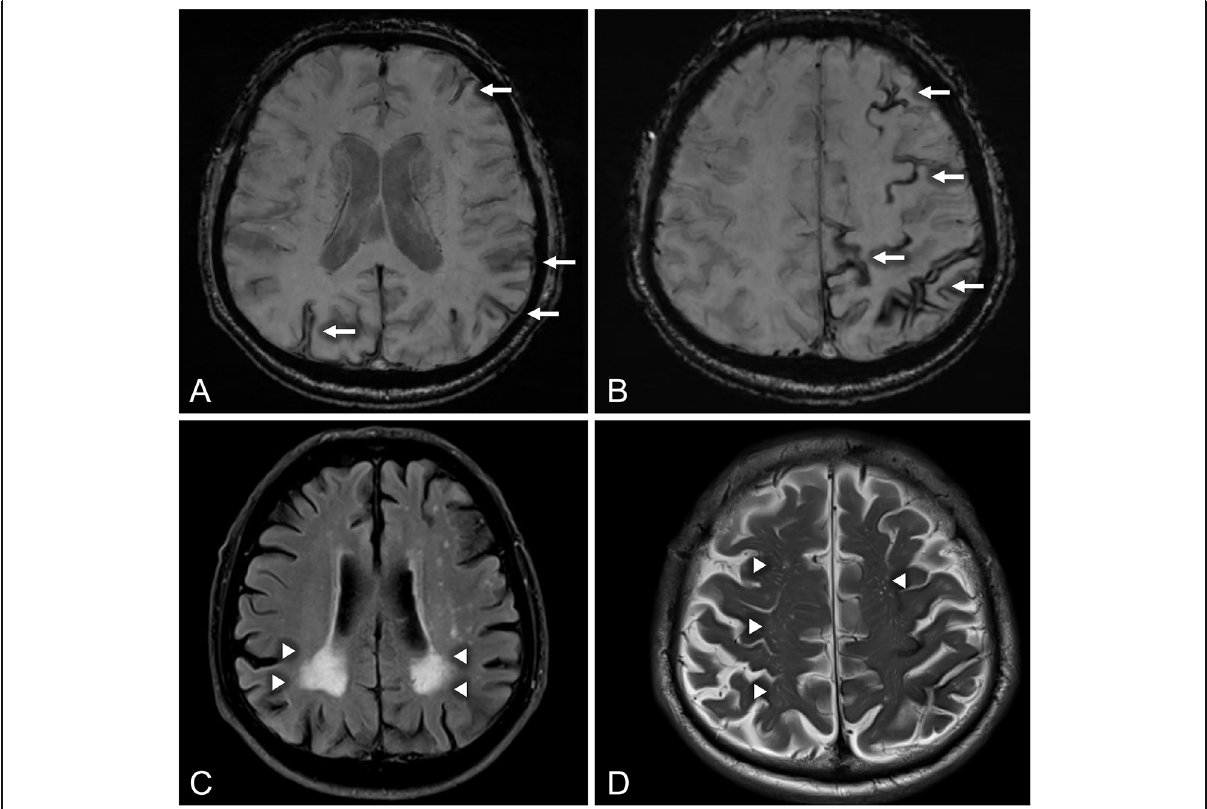
Fig. 1 Neuroimaging findings in a patient with transient focal neurological episodes. Legend: Axial brain MRI with susceptibility-weighted imaging sequence showing rims of low signal coating the sulci of both cerebral hemispheres with left predominance, suggestive of cortical superficial siderosis (Panel a - b , arrows). Axial brain MRI with fluid-attenuated inversion recovery sequence showing symmetrical periventricular white matter hyperintensities with occipital predominance of Fazekas grade 3 (Panel c , arrowheads). Axial brain MRI with T2-weighted imaging showing enlarged perivascular spaces in centrum semiovale (Panel d ,